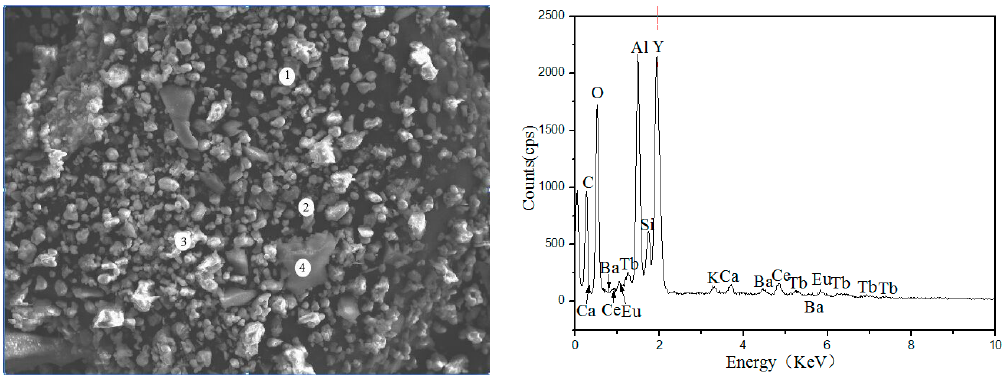
Figure 2. SEM-EDS analysis of waste phosphors. Table 2. EDS analysis of waste phosphors.